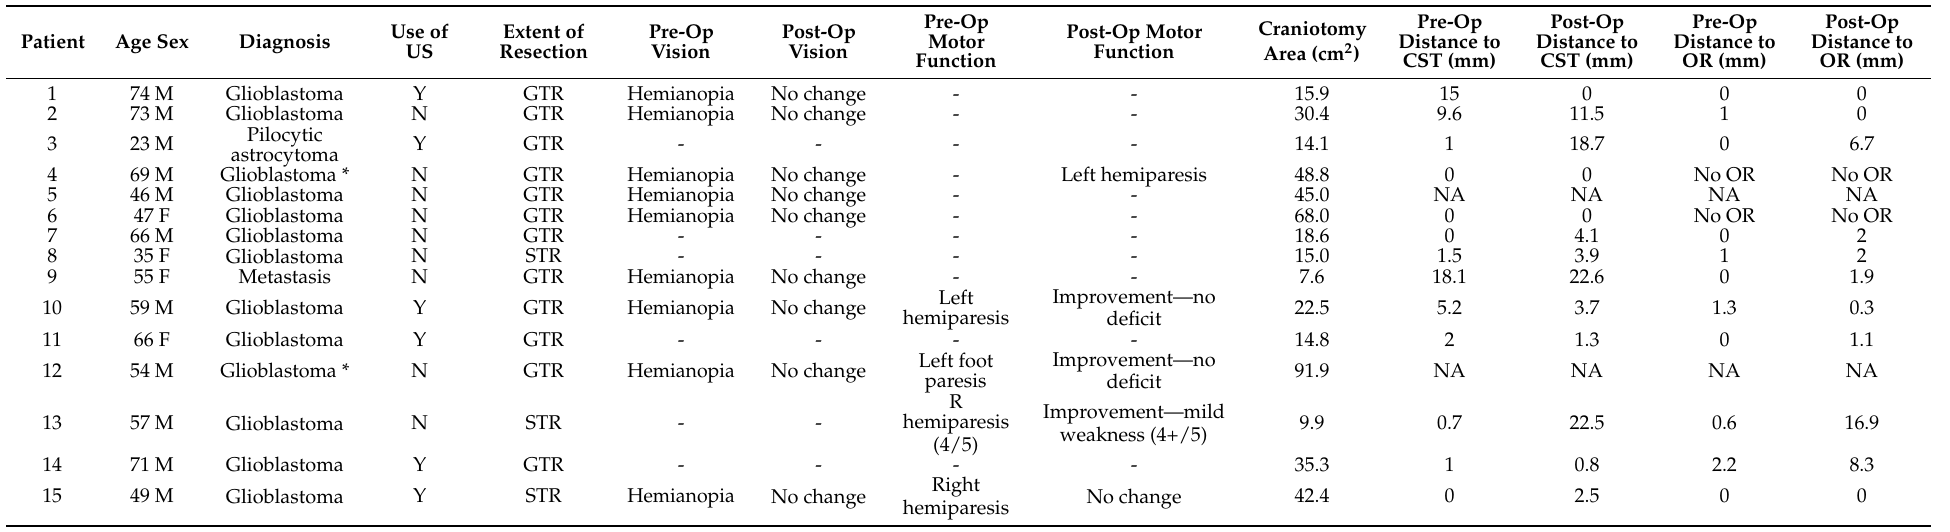
Table 1. Patient characteristics and clinical